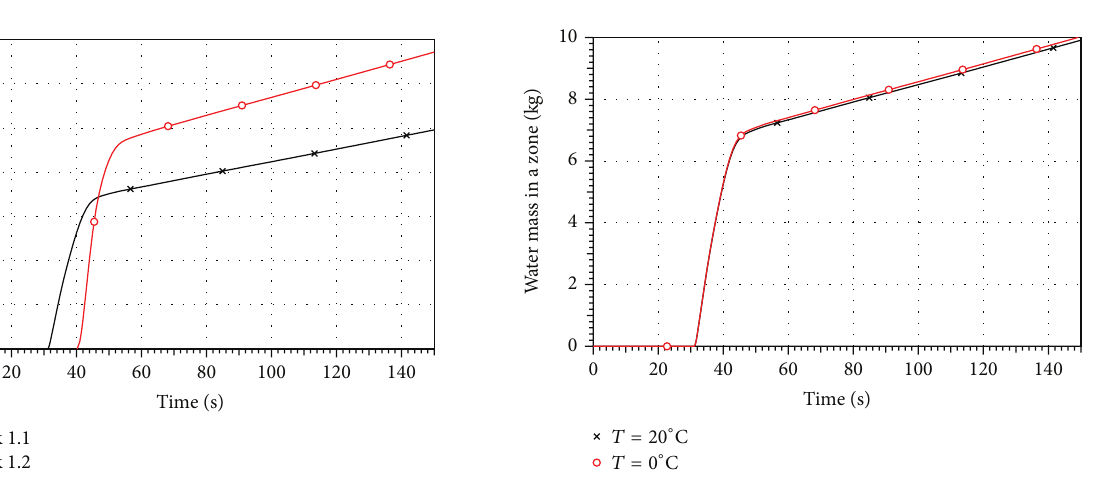
Figure 16: Temperature of outside environment 0 ∘ C: total water mass in